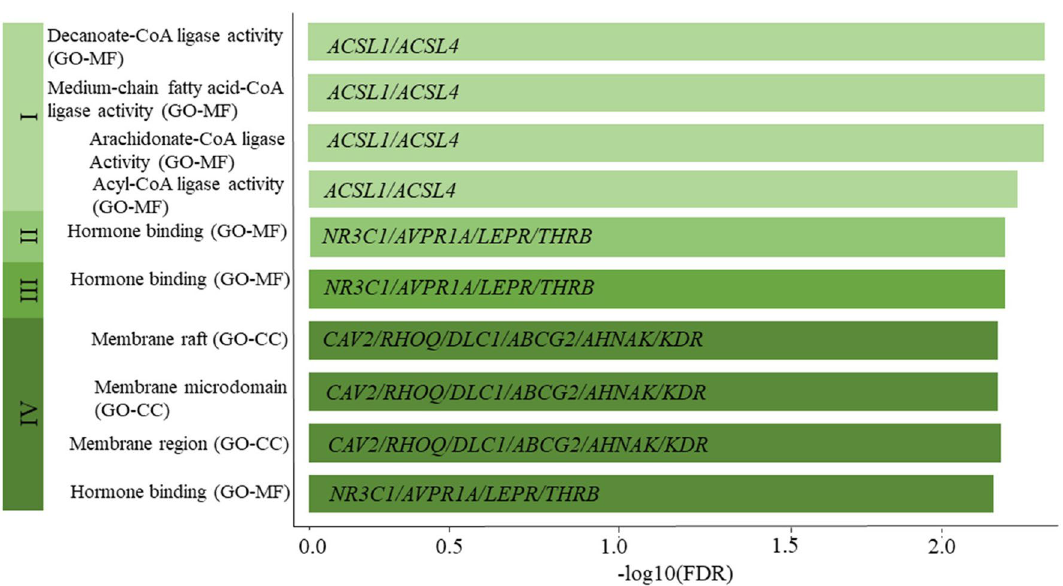
Figure 6. Pathway enrichment analysis results for genes included in stage-specific competing endogenous RNA networks in breast cancer 20 . Four, one, one, and four gene-ontology pathways were statistically significant in stages I, II, III, and IV, respectively. The CoA ligase activity-related pathways have been significant only in stage I. The hormone-binding pathway was significant among stages II, III, and